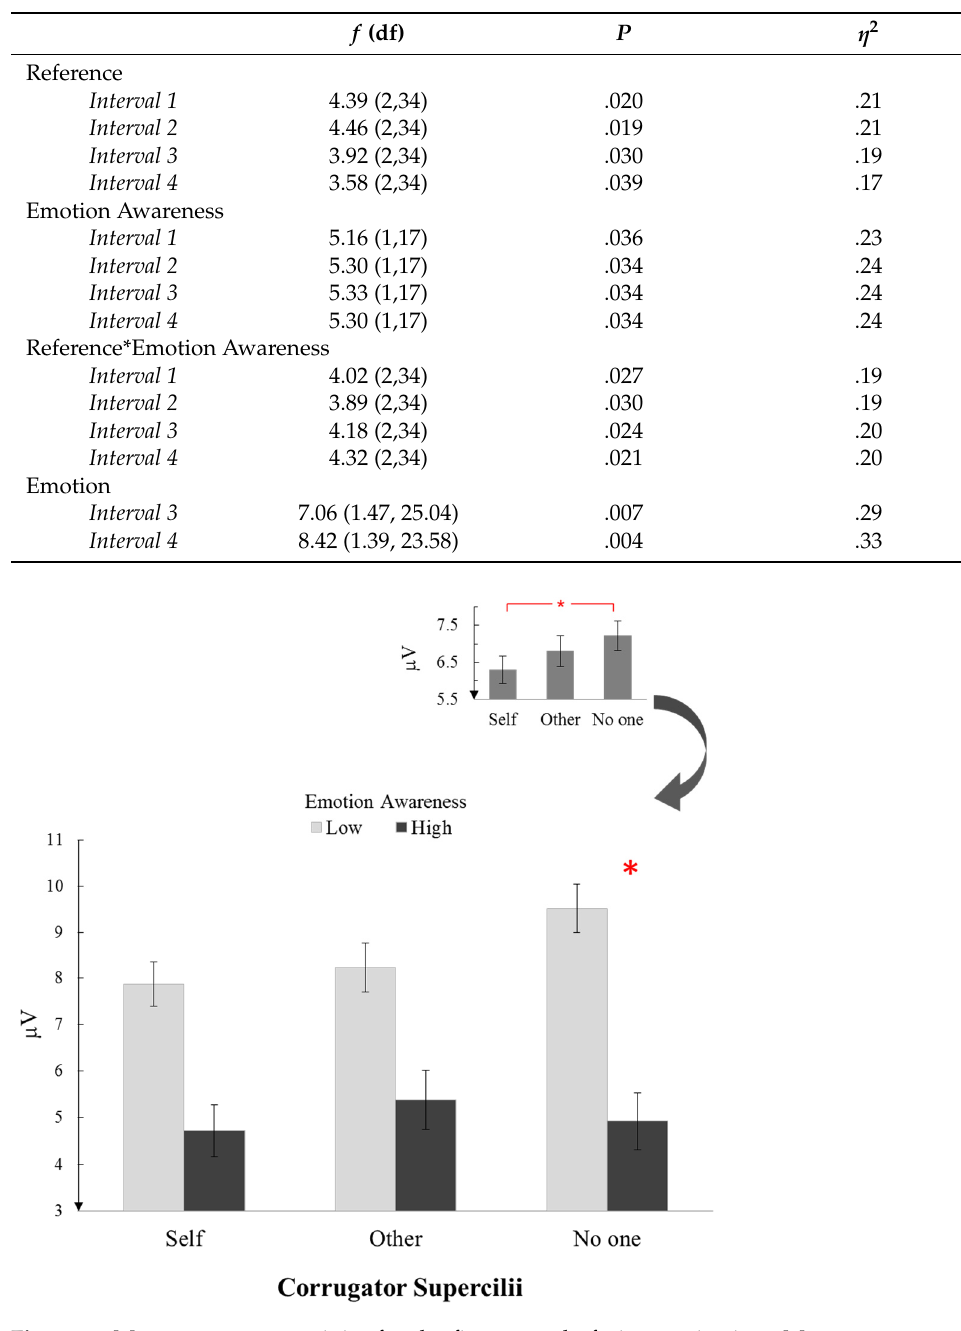
Figure 2. Mean corrugator activity for the first second of picture viewing. Means represent the average of all 250 ms time intervals for the respective conditions. Means were collapsed over emotion categories to show the cumulative effect of the referential conditions (smaller bar graph) and the effect of emotion awareness on referential conditions. Error bars represent 1 standard error. Asterisks mark variables with significant results.